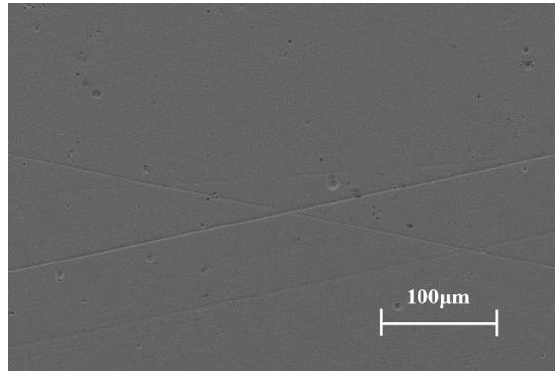
The cylinder liner as the mating pair was made of 38CrMoAl steel and had a mirror- like finish. The surface was processed with nitriding treatment. The inner diameter of the cylinder liner was 150 mm. The surface hardness and average surface roughness Ra of the cylinder liner was 820.4 HV and 0.2 µ m, respectively. Figure 7 shows the SEM micrograph of the liner surface. Honing marks with a cross-hatch angle of 25 ◦ can still be found on the surface.